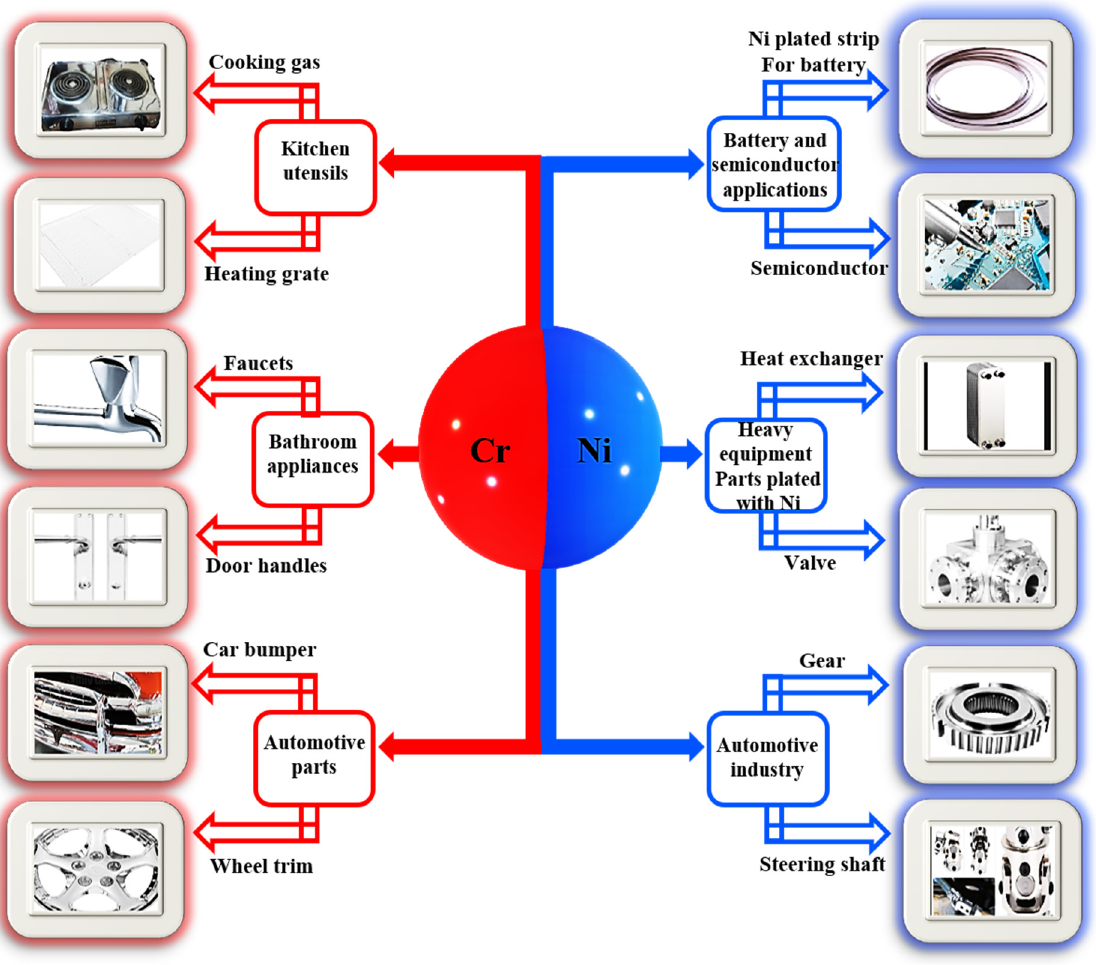
Figure 1. A schematic of the diverse applications of Cr and Ni electrodeposited coatings.